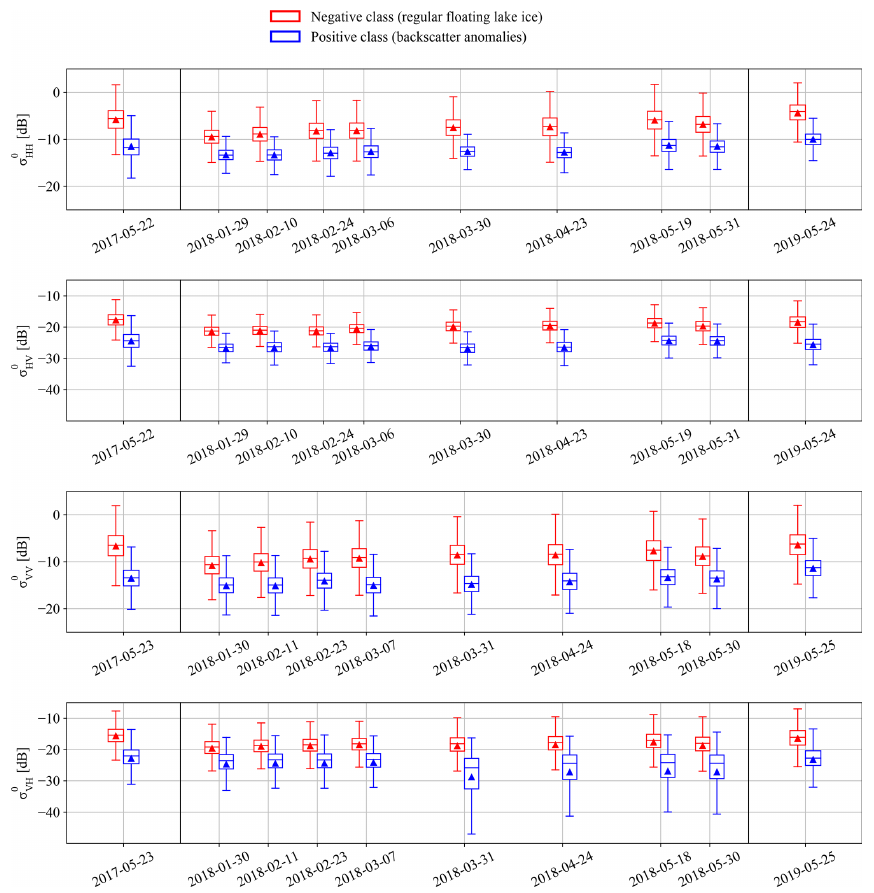
Figure 5. Boxplots of σ 0 for the positive class (backscatter anomalies) and negative class (regular floating lake ice) for all polarisations (HH, HV, VV, VH) and all 10 acquisition dates in the validation set. The means are represented by triangles. Dates are given in the format